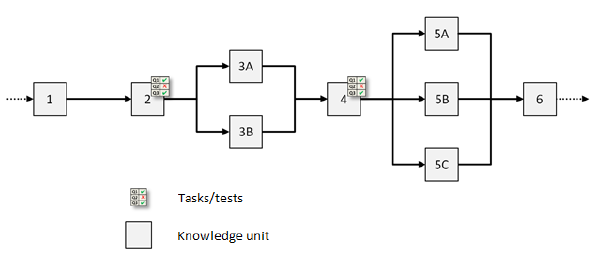
Figure 1. Adaptive learning to support individual learning paths.